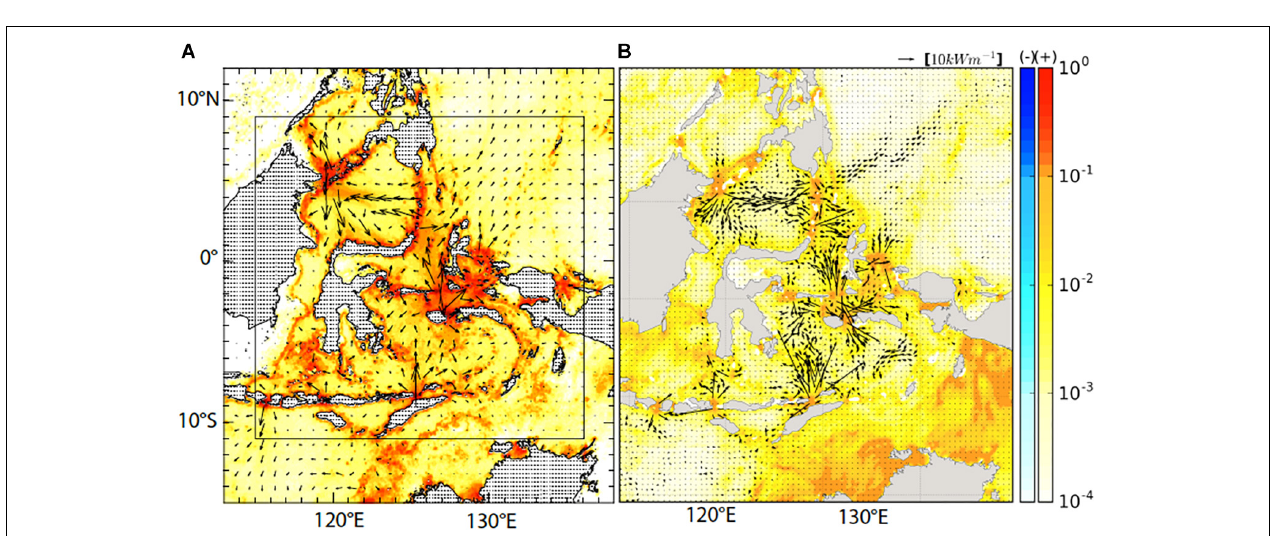
FIGURE 14 | Model predicted distribution of the depth-integrated baroclinic energy flux (kW/m; vector) and baroclinic energy dissipation (W/m 2 shading) from (A) NEMO (1/12 ◦ ) (Figure from Nugroho, 2017. Permission obtained from author) and (B) the MITgcm (1/100 ◦ ) (Figure from Nagai and Hibiya, 2015).